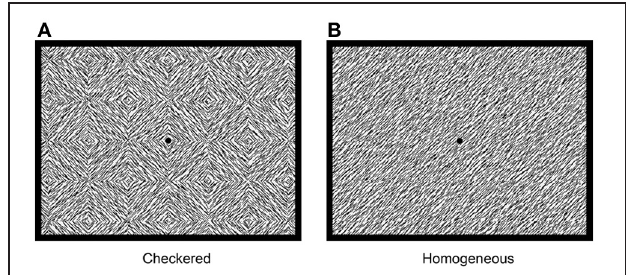
FIGURE 1 | Stimuli used for investigation of visual segmentation: checkered stimulus (A) and homogeneous stimulus (B).